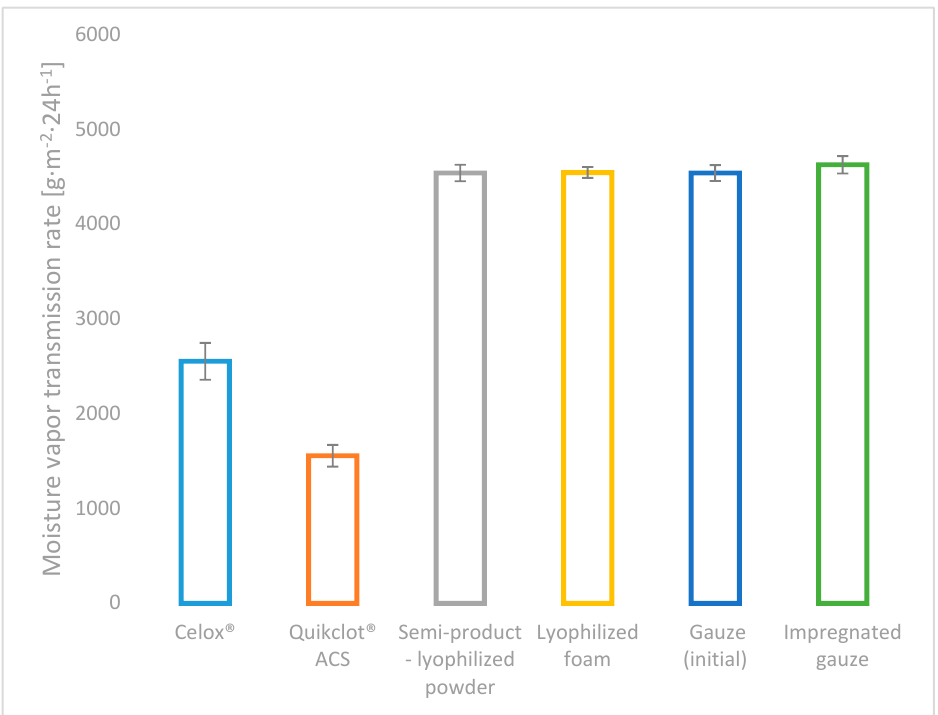
Figure 4. Moisture Vapour Transmission Rate (MVTR) of the references: Celox ® , Quikclot ® ACS, semi-product—lyophilized powder [15], gauze and the studied usable forms of the haemostatic agents: lyophilized foam and impregnated gauze.